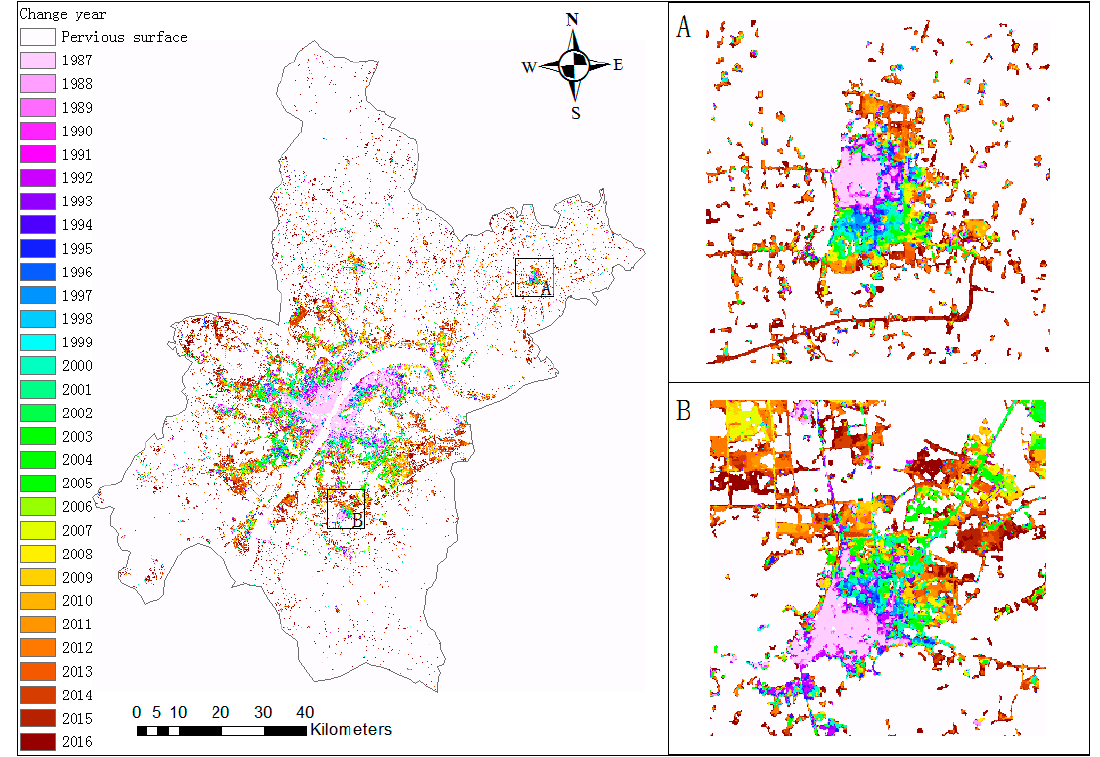
Figure 8. The annual change of impervious surface maps in Wuhan city.